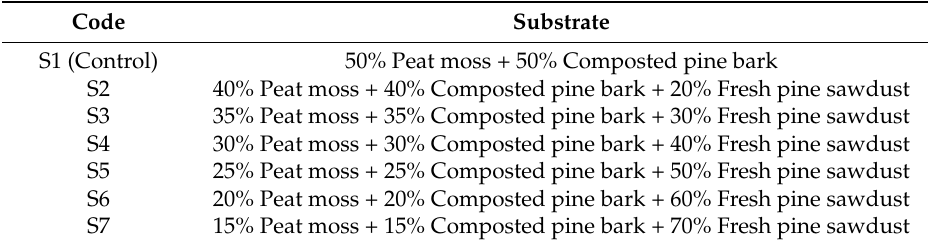
Table 1. Substrates evaluated in the production of Pinus engelmannii seedlings in the nursery, during the crop cycle of September 2015 to June 2016. Code Substrate